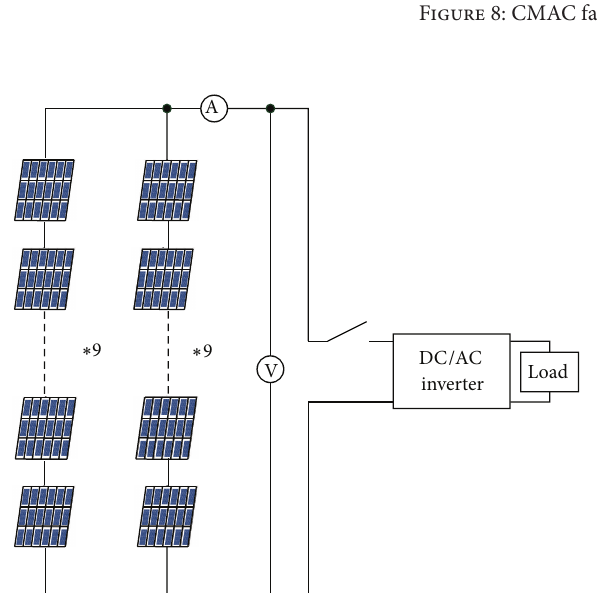
Figure 8: CMAC fault diagnosis framework.